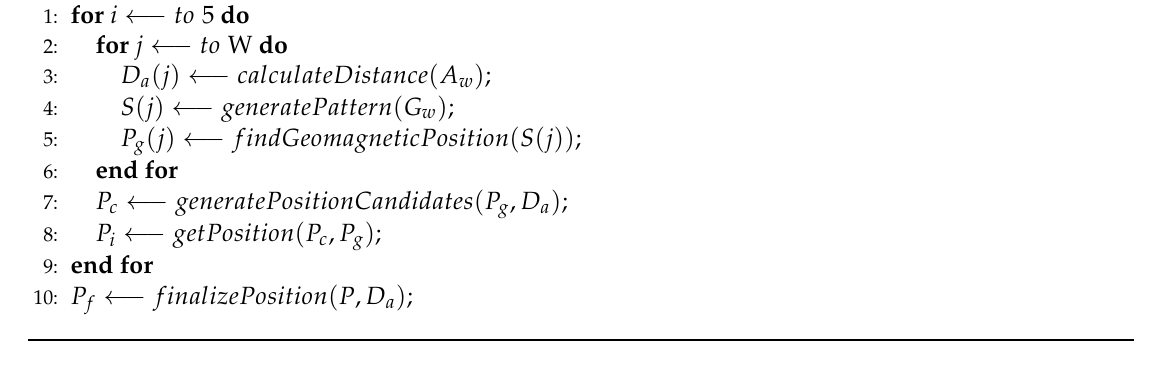
Algorithm 2 User positioning using geomagnetic and acceleration data.